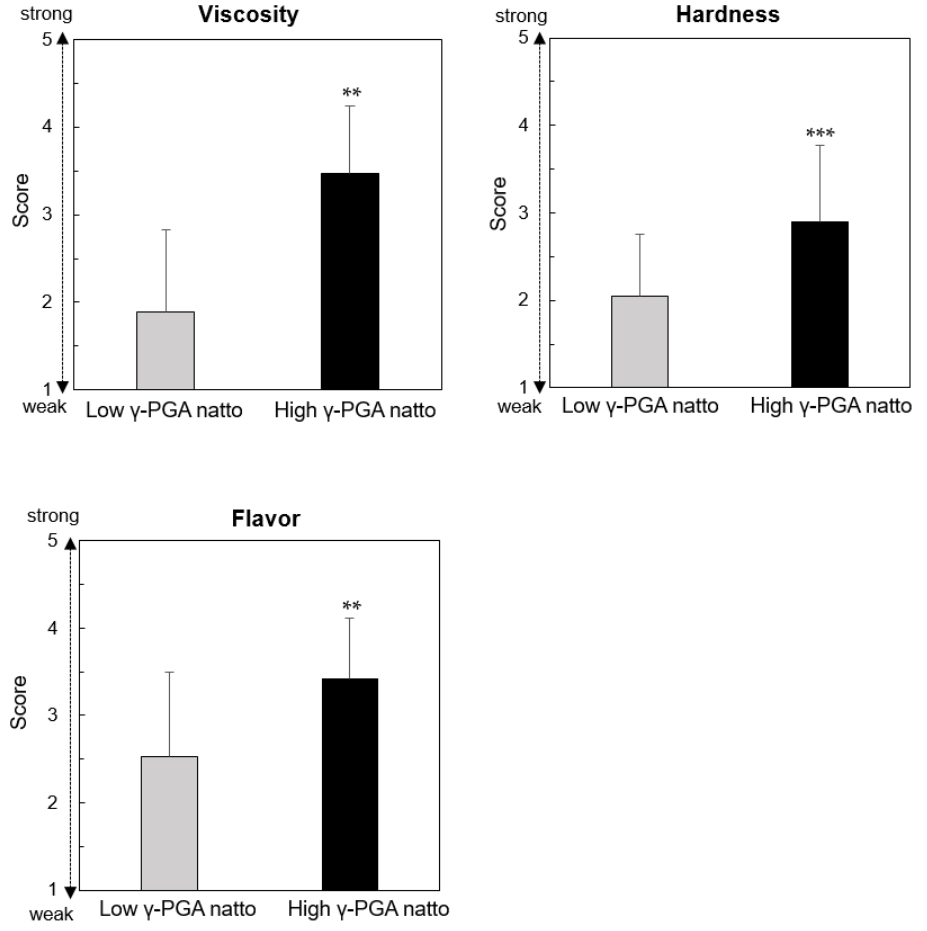
Figure 2. Sensory evaluations of the natto used in the present study. “Viscosity,” “hardness,” and “flavor” of high- and low- γ -PGA natto were compared using a paired t -test, and the data are shown as the mean ± the standard deviation (mean ± SD). ** p < 0.01, *** p < 0.001 vs. low- γ -PGA natto. γ -PGA: gamma-polyglutamic acid.